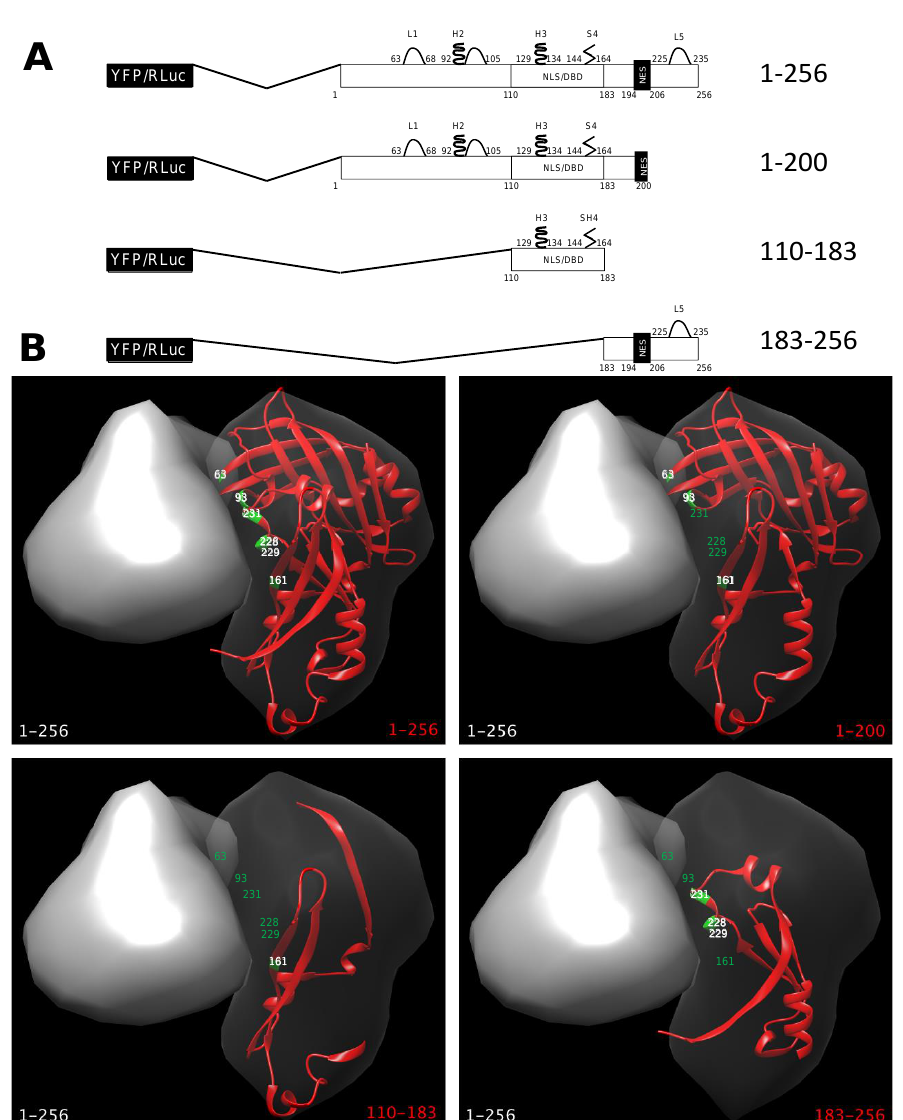
Figure 1. M deletion mutants used in this study ( A ) Schematic representation of R espiratory syncytial virus (RSV) matrix (M) deletion mutants used in this study as fused to either YFP, RLuc and cyan fluorescent protein (CFP). Elements involved in dimerization are shown, based on the nomenclature used in [26] . L1, loop 1 (aas 63–88); H2, helix 2 and downstream loop (aas 92–105); H3, helix 3 (aas 129–134); S4, sheet 4 (aas 144–163); L5, loop 5 (225–235); NLS/DBD, nuclear localization sequence/DNA binding domain (residues 110–183); NES, nuclear export sequence (aas 194–206); YFP, yellow fluorescent protein; RLuc, Renilla luciferase; ( B ) The recently solved M dimeric structure (PDB code 4V23) was used to highlight the key aas involved in M dimerization and their position relative to each deletion mutant tested in this study, using software Chimera as described in the Materials and Methods section. The surface of a full-length M monomer (1–256) is shown as a grey structure in combination with the M versions used in this study, shown as red ribbons. Key residues involved in dimerization in the latter subunit are shown in green. Residue labels are shown either in white or green, depending on their presence or absence in the corresponding deletion mutant,